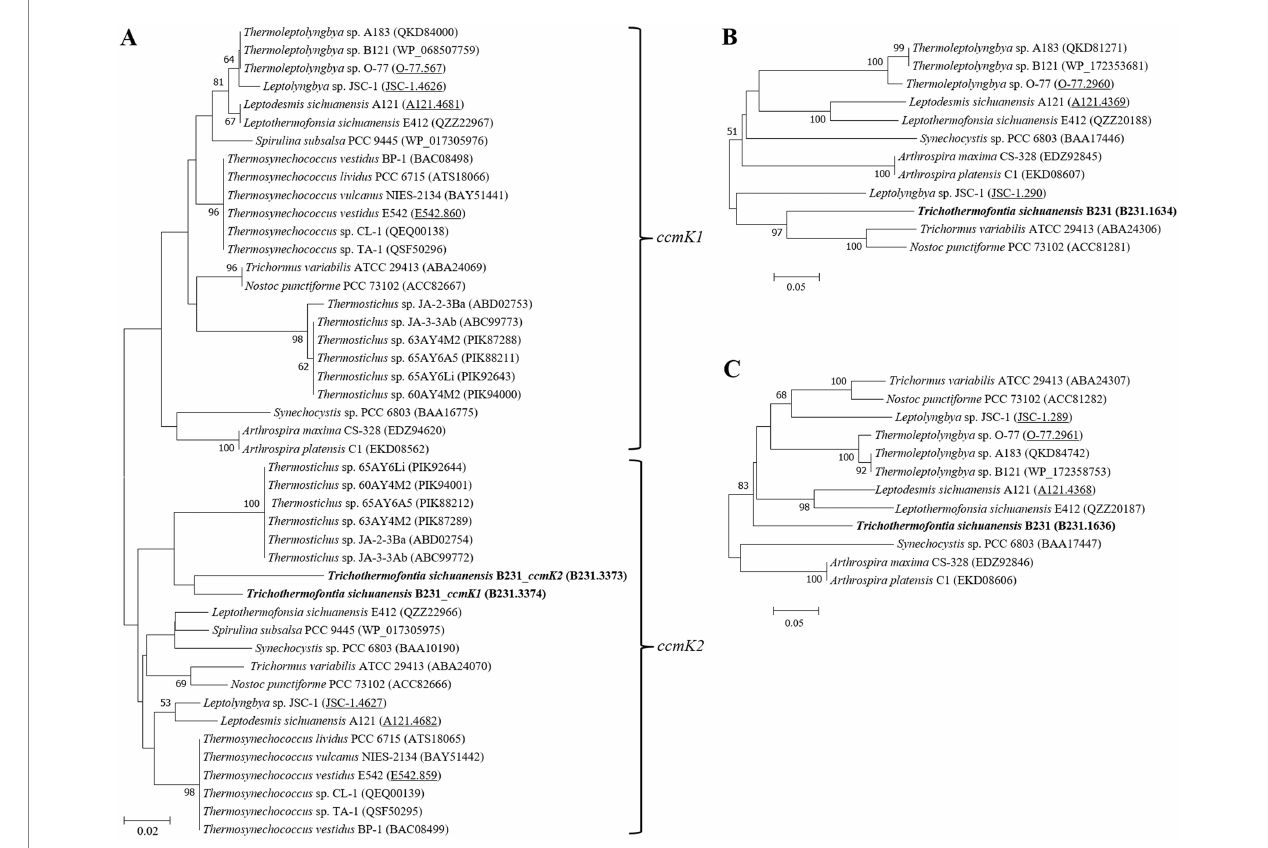
FIGURE 5 ML phylogenetic inference of protein sequences of ccmK1/2 (A) , ccmK3 (B) , and ccmK4 (C) . The thermophilic cyanobacterium investigated in this study is indicated in bold. The accession numbers underscored refer to the gene IDs in Supplementary Table 1 or the reference (Tang et al., 2022d).